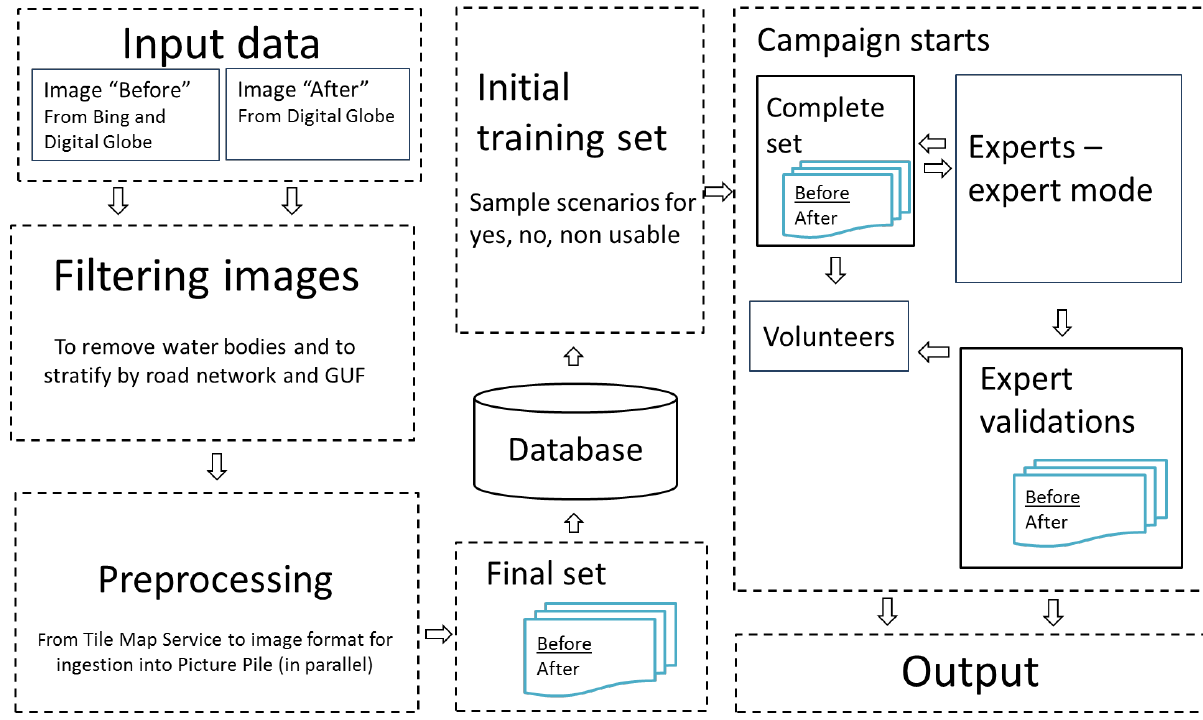
Figure 2. An overview of the methodology used to assess building damage with Picture Pile